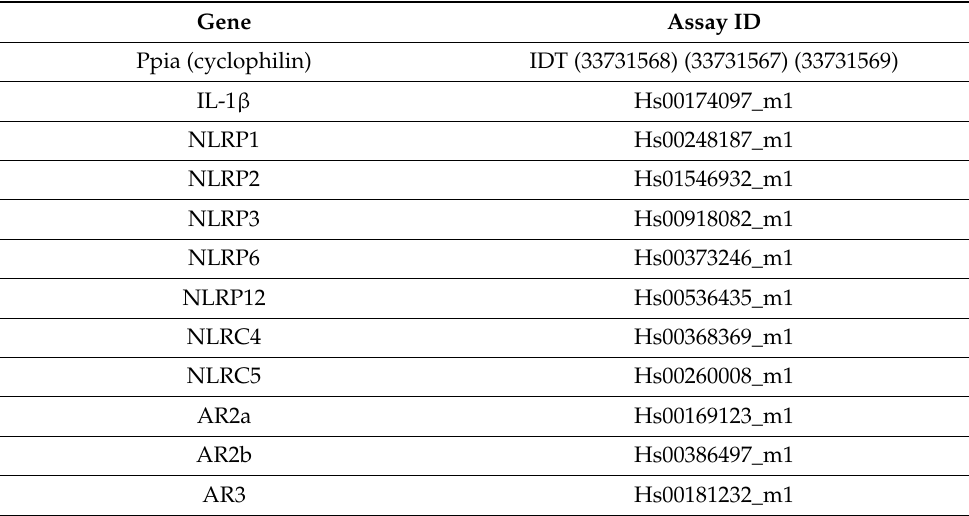
Table 1. List of the gene expression assays.